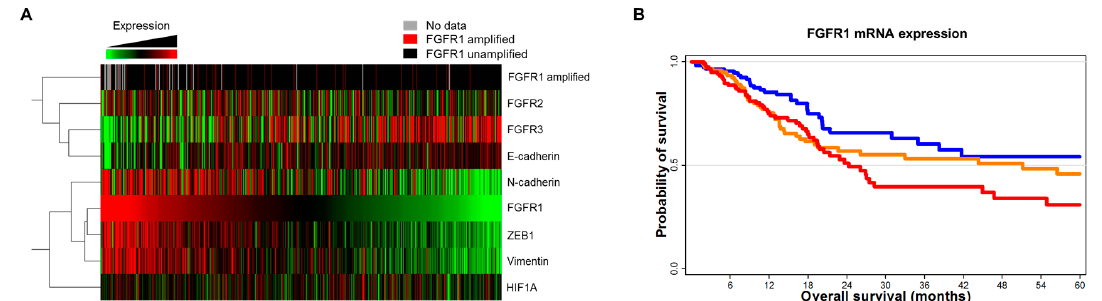
Figure 2. FGFR1 expression is correlated with EMT marker levels in TCGA data. ( A ) Gene expression and alteration profiles from TCGA cohort (http://www.cbioportal.org). ( B ) Survival analysis according to FGFR1 mRNA expression (red: upper third, orange: mid third, Blue: lower third).